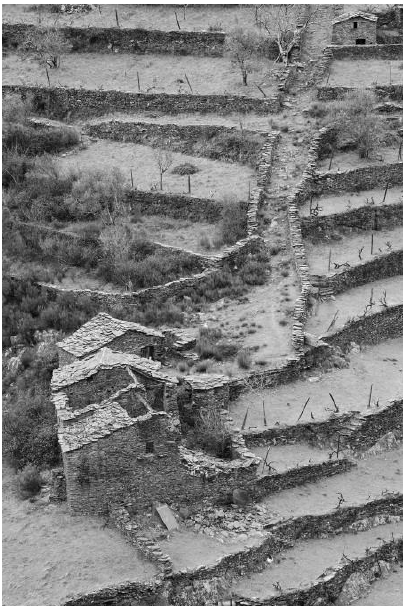
Figure 20. Abandoned terraces in Alto Douro .